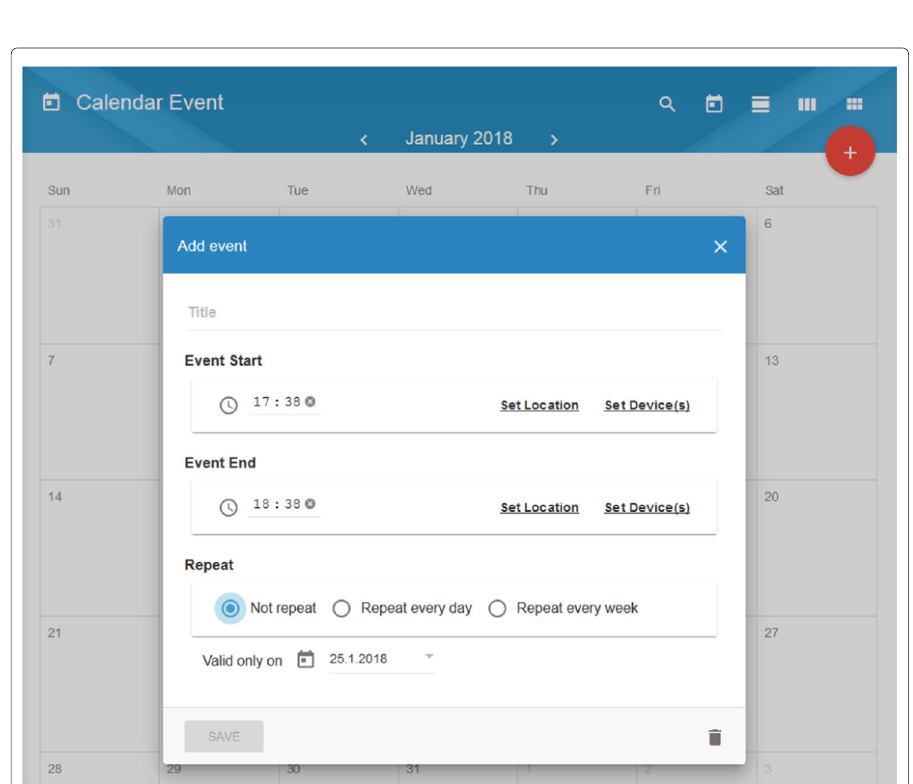
Fig. 20 BOS UI: the dialog box of adding a calendar